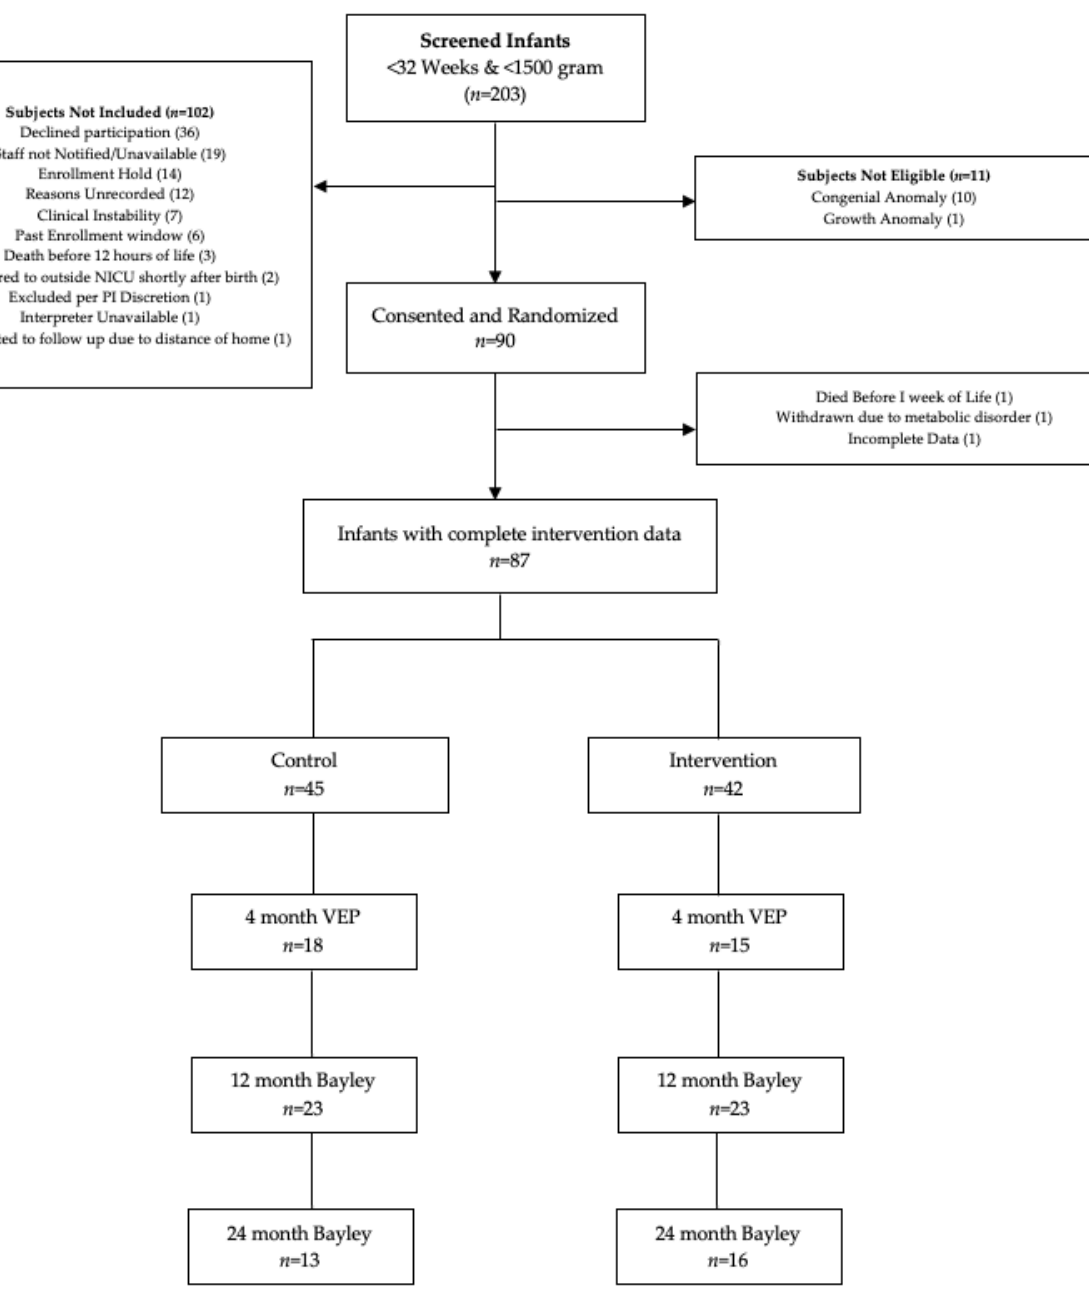
Figure 1. Flow diagram of study